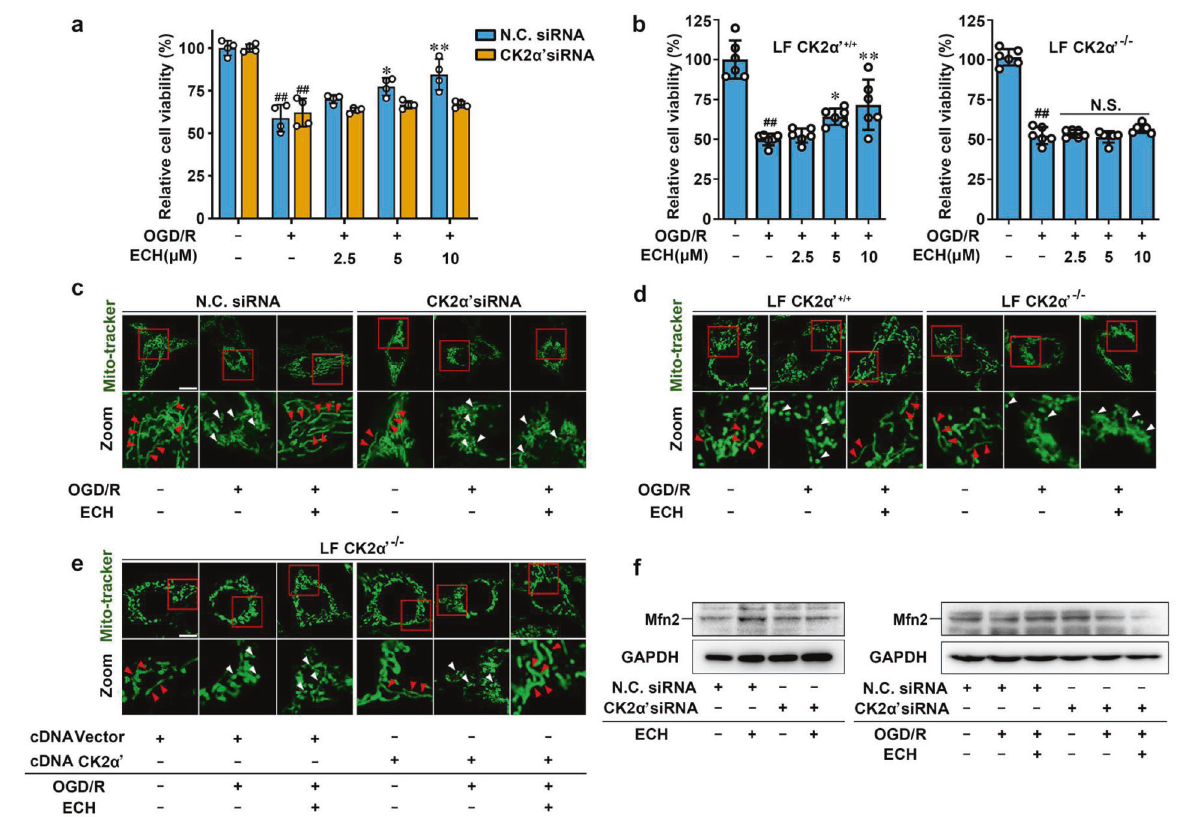
Fig. 3 CK2 α ′ plays a fundamental role in modulating mitochondrial fusion. a CK2 α ′ knock-down reversed ECH-dependent increase in cell viability against OGD/R insult, which was detected by MTT assay. b ECH increased cell viability against OGD/R-induced injury in CK2 α ′ + / + lung fi broblasts, which was signi fi cantly suppressed in CK2 α ′ − / − cells. c ECH-induced mitochondrial fusion was suppressed in CK2 α ′ knock-down cells, which was indicated by Mito-tracker staining. Arrows (red) indicate branched healthy mitochondria. Arrows (white) indicate spherical dysfunctional mitochondria (scale bar: 20 μ m). d ECH-induced mitochondrial fusion was inhibited in CK2 α ′ − / − cells, which was indicated by Mito-tracker staining. Arrows (red) indicate branched healthy mitochondria. Arrows (white) indicate spherical dysfunctional